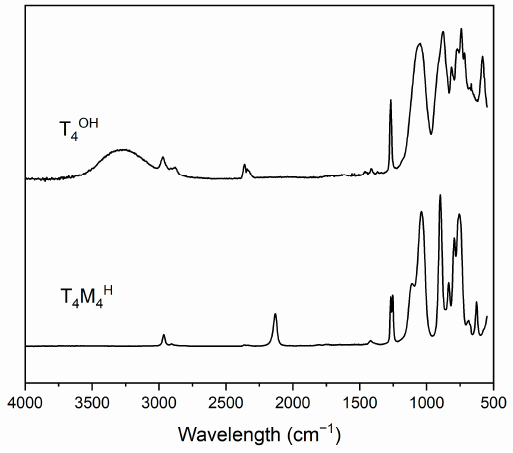
Figure 2. IR spectra of intermediate products in monomer synthesis.